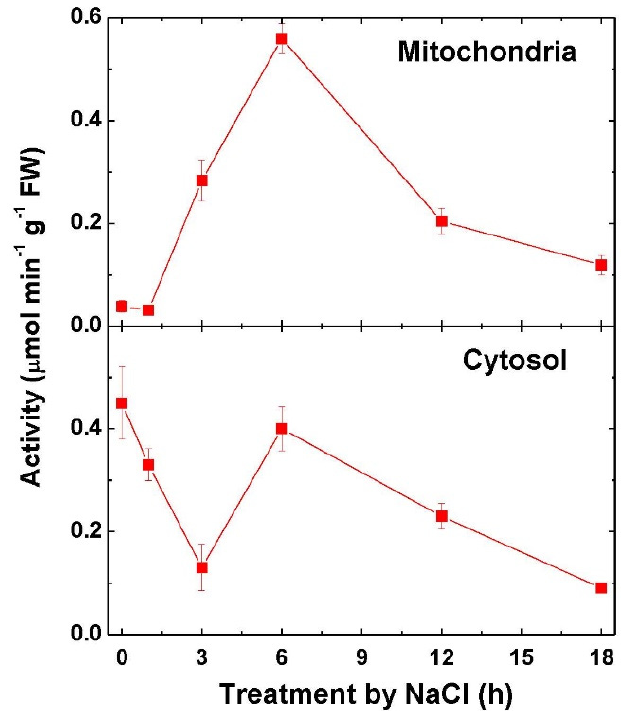
Figure 2. Change in activity of aconitase in the mitochondrial and cytosolic fractions after the transfer of maize seedlings to 150-mM NaCl. The data represent the means of three biological repeats ± SD. The control (untreated) samples of activities did not exhibit statistically significant changes in the variation level during the